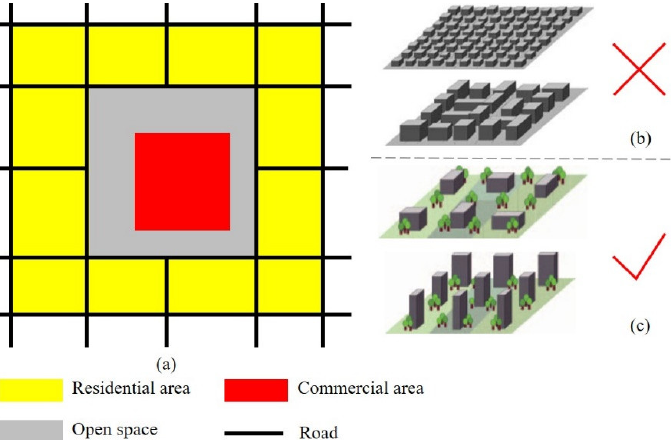
Figure 6. Planning strategies for the spatial layout of a commercial area: ( a ) The ideal special relationships between a commercial area and a traditional residential area, an open space is located between them; ( b ) traditional residential area, which is similar to LCZ 2 (compact mid-rise) and LCZ 3 (compact low-rise); ( c ) optimized residential area, which is similar to LCZ 4 (open high-rise) and LCZ 4 (open mid-rise).